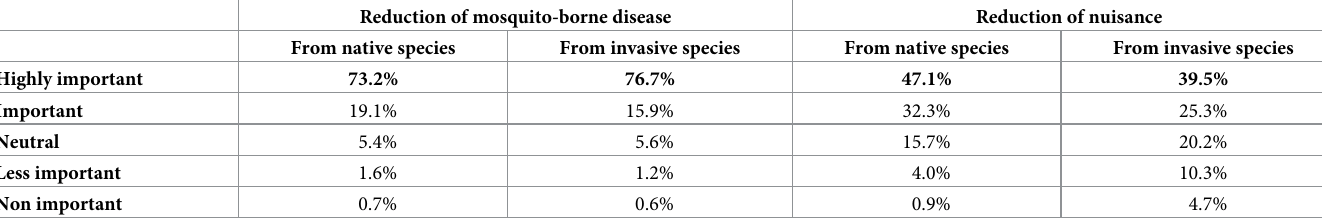
Table 5. Rating of the objectives of mosquito control programs’ (web-survey results) based on the answers of 1220